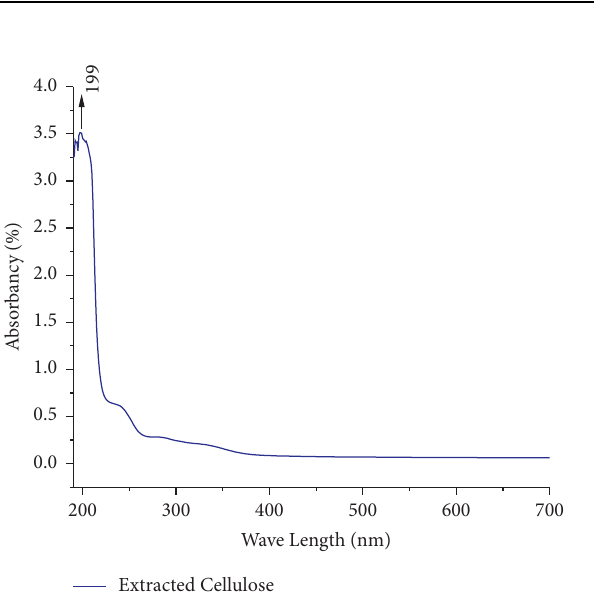
Figure 5: UV spectrometer analysis for extracted bagasse cellulose.